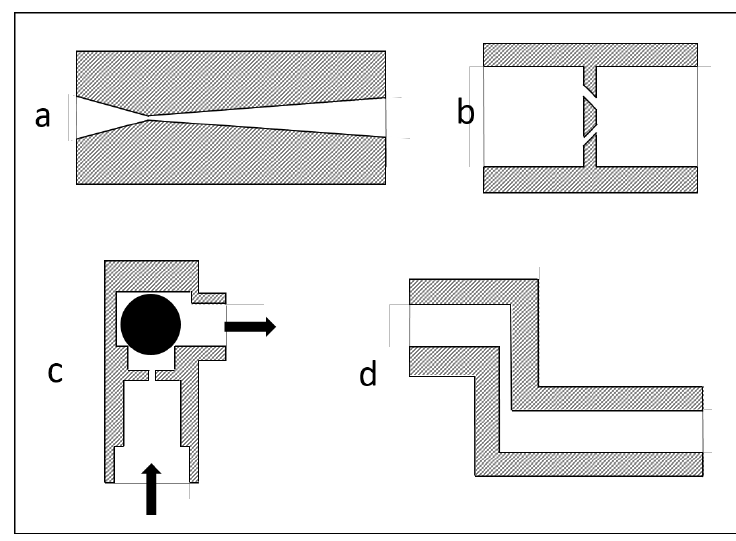
Figure 2. Modifications of orifices. ( a ) Concial orifice adapted from [27]; ( b ) Two beam jet valve adapted from [44]; ( c ) Valve with impact bead adapted from [41]; ( d ) Redirecting valve adapted from [43].